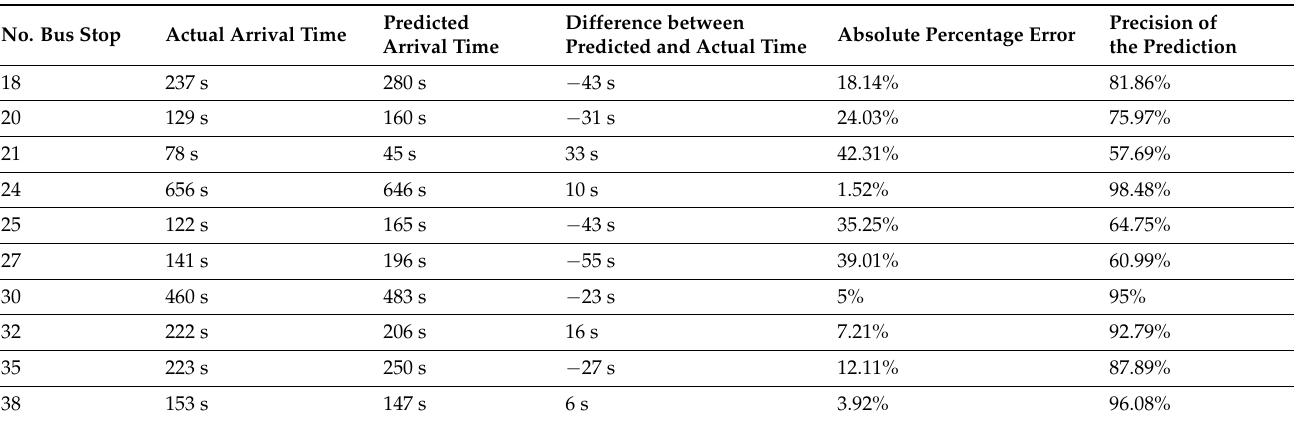
Table 4. Results obtained for Trip 4, Journey: University–Guacamayas. MAE = ± 28.7 s, MAPE = 18.8% Precision = 81.2%.